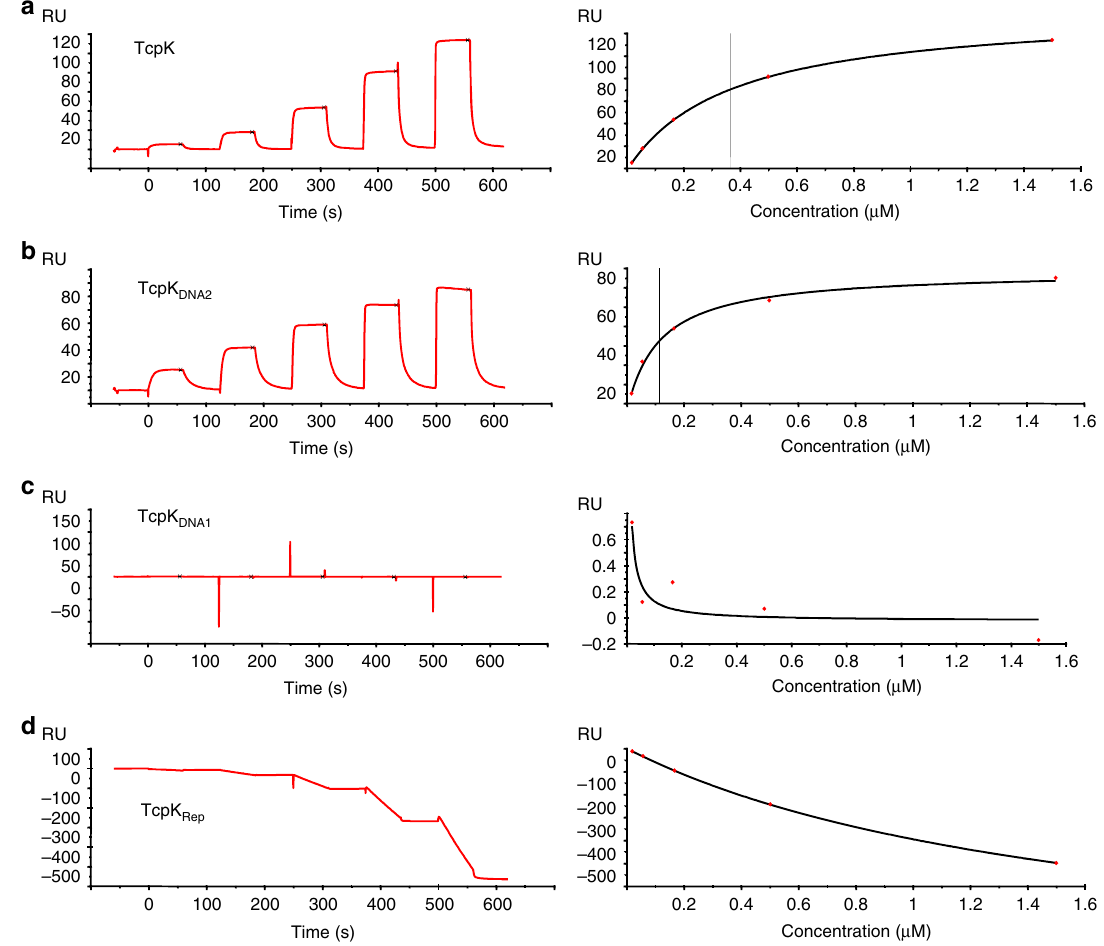
Fig. 5 SPR binding analysis of TcpK binding to oriT fragments. Single-cycle steady-state af fi nity analysis of TcpK substitution derivatives binding to oriT min23 . The left panels represent sensorgrams obtained for a TcpK, b TcpK DNA2 , c TcpK DNA1 and d TcpK Rep with protein concentrations of 18.5 nM, 55.6 nM, 166.7 nM, 500 nM and 1.5 μ M. The right panels are the respective steady-state af fi nity fi t